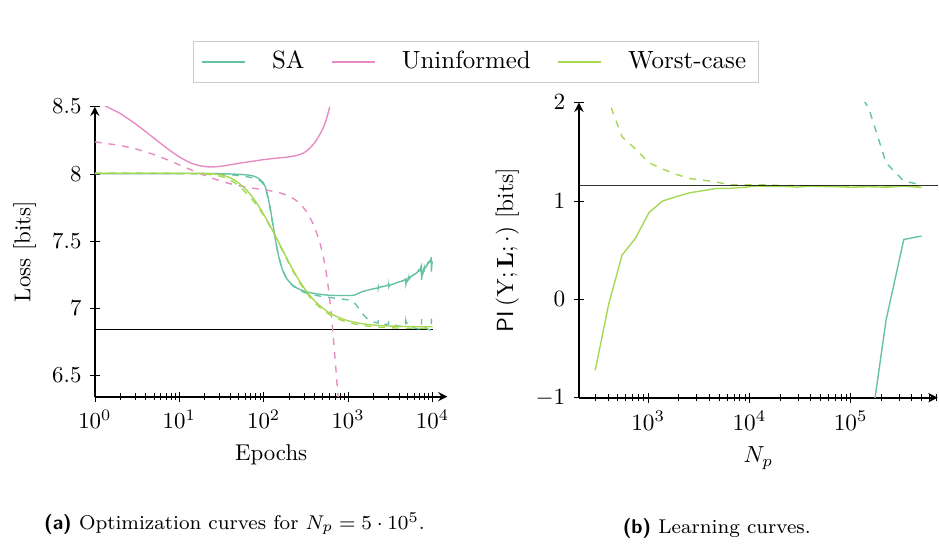
Figure 6: Comparison between models for an affine